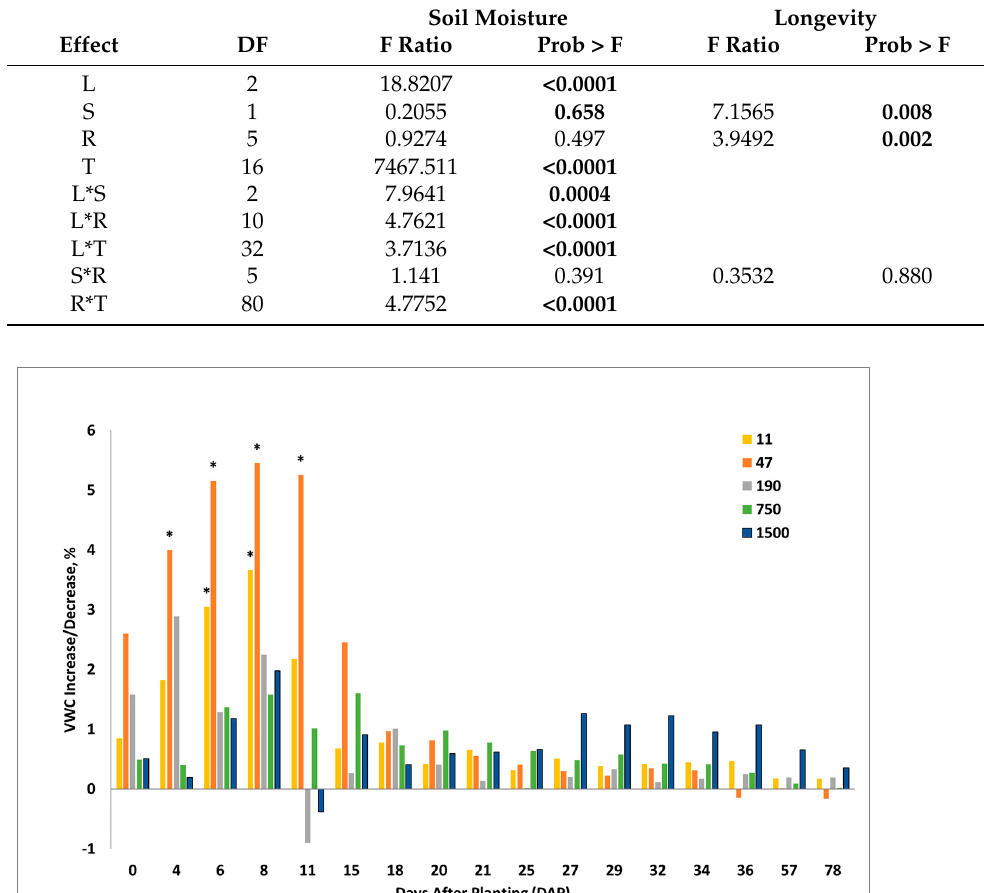
Table 7. Statistical results of a glass house study evaluating the effect of species (S), planting location (L), SAP rate (R), time (T), and their interactions on soil moisture, as well as the effect of species and location on seedling longevity. Bolded numbers indicate p < 0.05.